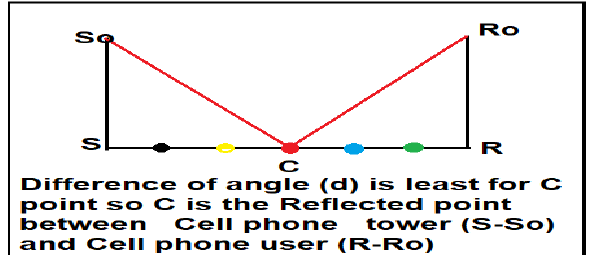
Figure 11. Reflected point found by Difference of angle